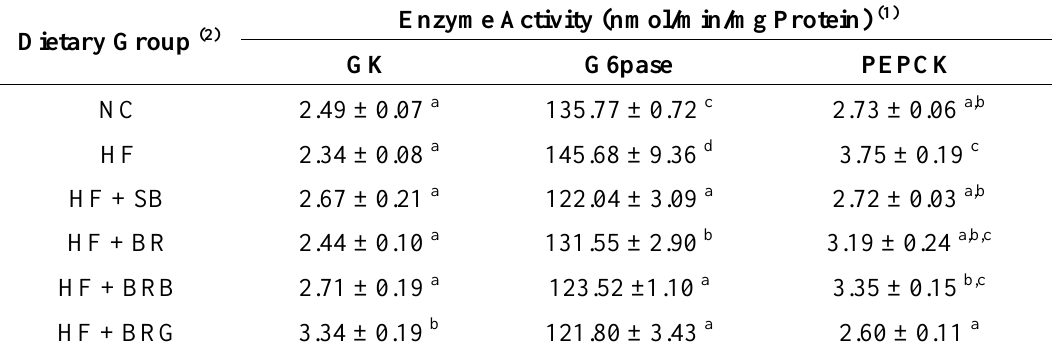
Table 5. Hepatic glucose-regulating enzyme activity in mice fed with high fat diet supplemented with fermented rice paste.